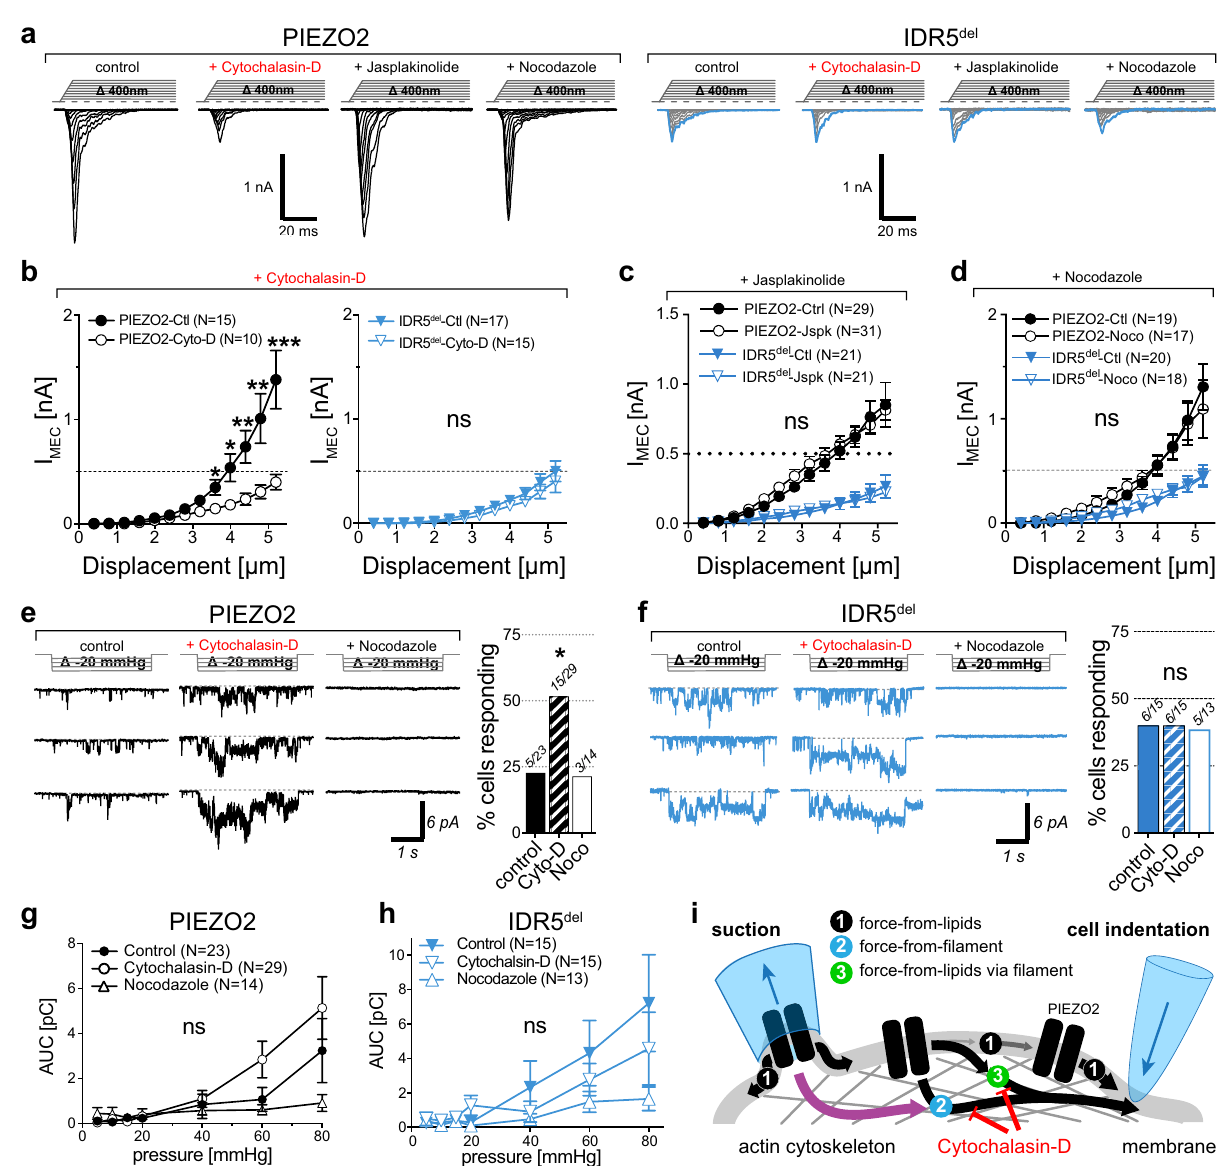
Fig. 5 Actin cytoskeleton disruption impairs PIEZO2- but not IDR5 del -mediated membrane indentation-evoked currents. a Example traces of poking- evoked PIEZO2 (left) and IDR5 del (right) whole-cell currents recorded under the indicated conditions. b Displacement-responses curves of peak current amplitudes of PIEZO2 (left) and IDR5 del (right) in the absence (control) or after treatment with Cytochalasin-D (15 min, 1 µ M). Displacement-responses curves of peak current amplitudes of PIEZO2 and IDR5 del in the absence (control) or in the presence of Nocodazole (30 min, 1 µ M) ( d ) or Jasplakinolide (1 h, 200 nM) ( c ). For b – d symbols are mean ± s.e.m. Comparison of treated vs. untreated cells using Mann – Whitney test: P -Values for PIEZO2-Ctl vs PIEZO2-Cyto-D (from left to right): *0.047, *0.019, **0.009, **0.004, ***0.0009. N-numbers of cells per group are indicated in respective graph legend. Representative example traces of pressure-evoked currents recorded at -100mV in the cell-attached mode from untreated (control, left), Cytochalasin-D treated (middle) and nocodazole treated (right) N2a cells expressing PIEZO2 ( e ) and IDR5 del ( f ) as well as comparison of the proportions of cells responding to stretch under the respective conditions. Fisher ’ s exact test, PIEZO2-control vs Cytochalasin-D * p = 0.0441. N-number of cells are indicated in the graph. Pressure-responses curves of PIEZO2 ( g ) and IDR5 del ( h ) mediated pressure-evoked currents recorded in the indicated conditions. Symbols represent means± s.e.m., which were compared using the Kruskal – Wallis test. N-number of cells per group is indicated in the graph legend. i Cartoon depicting the possible gating mechanisms of PIEZO2 in the pressure-clamp and the poking assays. Negative pressure applied to cell-attached patches (suction, left) stretches the membrane and supposedly activates PIEZOs by force-from-lipids. Poking of the cell surface with a fi re-polished glass pipette inevitable causes both, stretch and cytoskeletal movements. Hence, in this con fi guration PIEZOs might be activated by (1) force-from-lipids, (2) by forces directly transmitted to channel by the cytoskeleton (force-from- fi lament), or (3) the cytoskeleton might relay forces to the membrane such that PIEZOs are eventually gated by membrane stretch (force-from-lipids-via- fi lament). Source data are provided as a Source Data fi le.